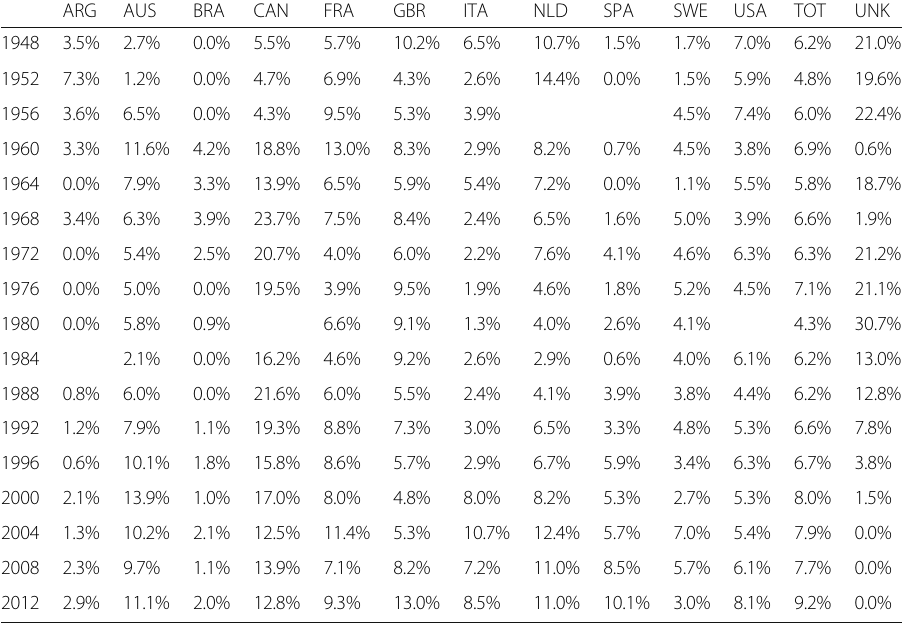
Table 1 Share (%) foreign-born athletes by country by edition